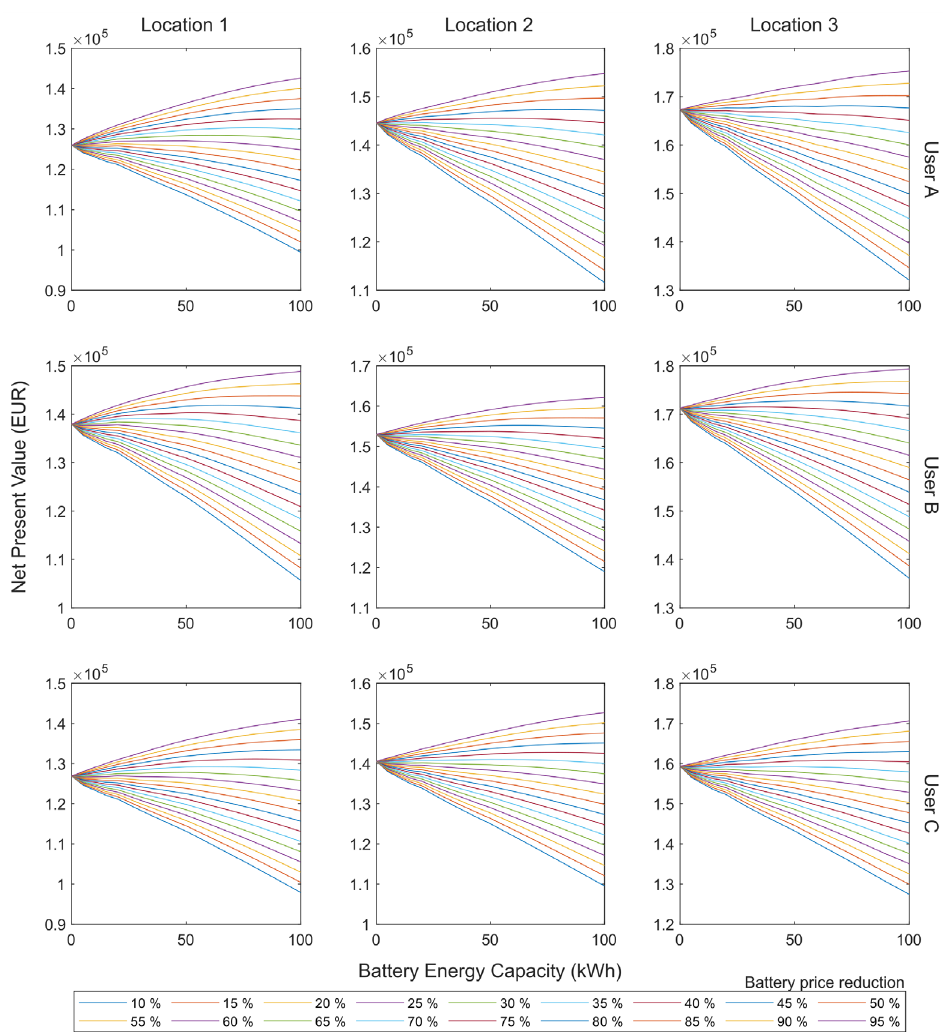
Figure 8. Optimal storage capacity according to battery prices for the users and locations analyzed using self-consumption model 2.